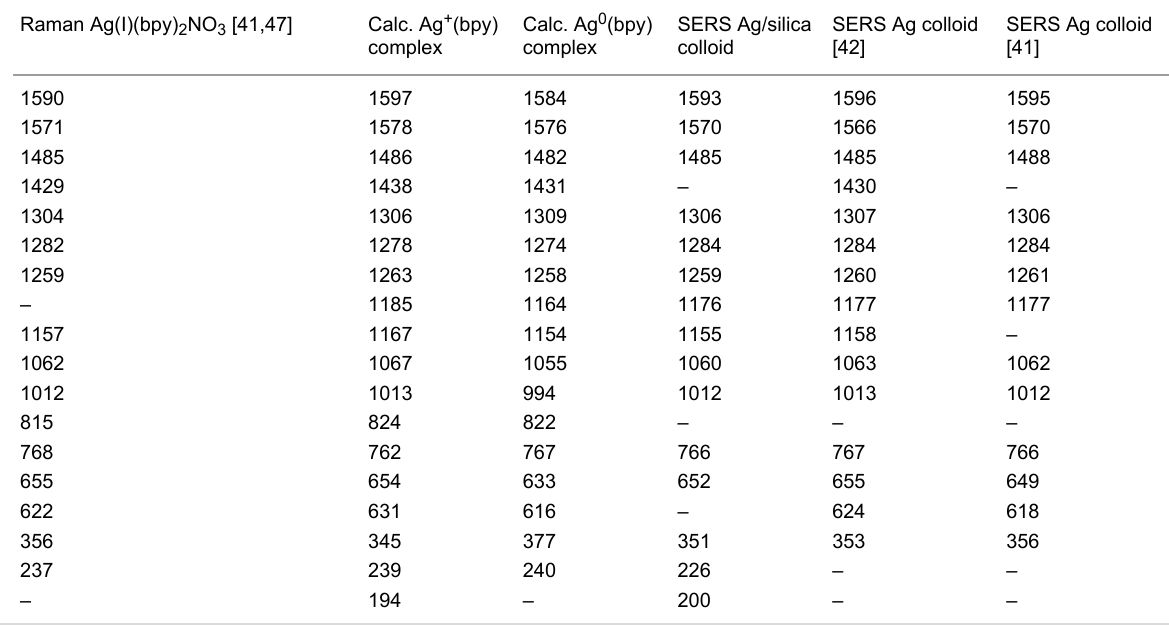
Table 1: Experimental and calculated frequencies (cm − 1